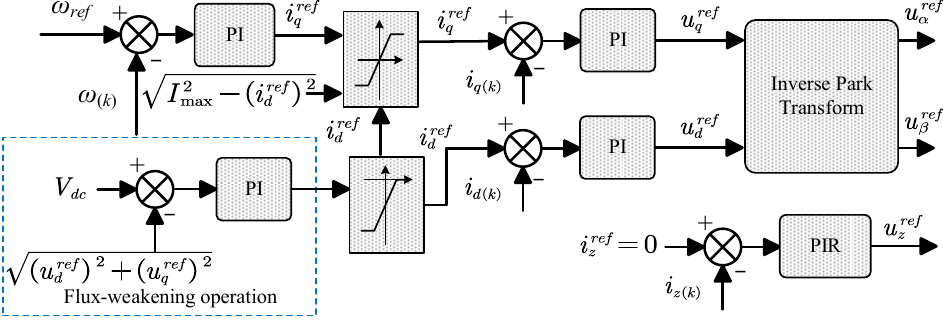
Figure 3. The control diagram of the conventional fl ux-weakening control strategy.